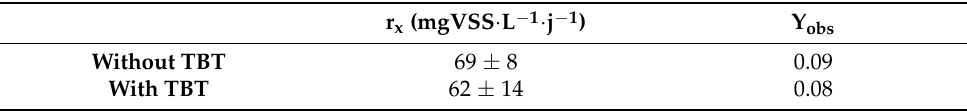
Table 2. Sludge production rate and conversion rate values measured during the